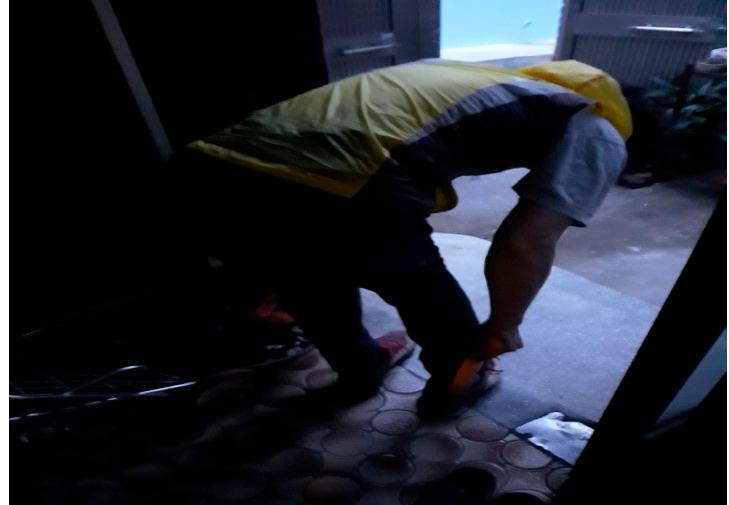
Figure 4. Weight management deterrents for breast cancer patients.